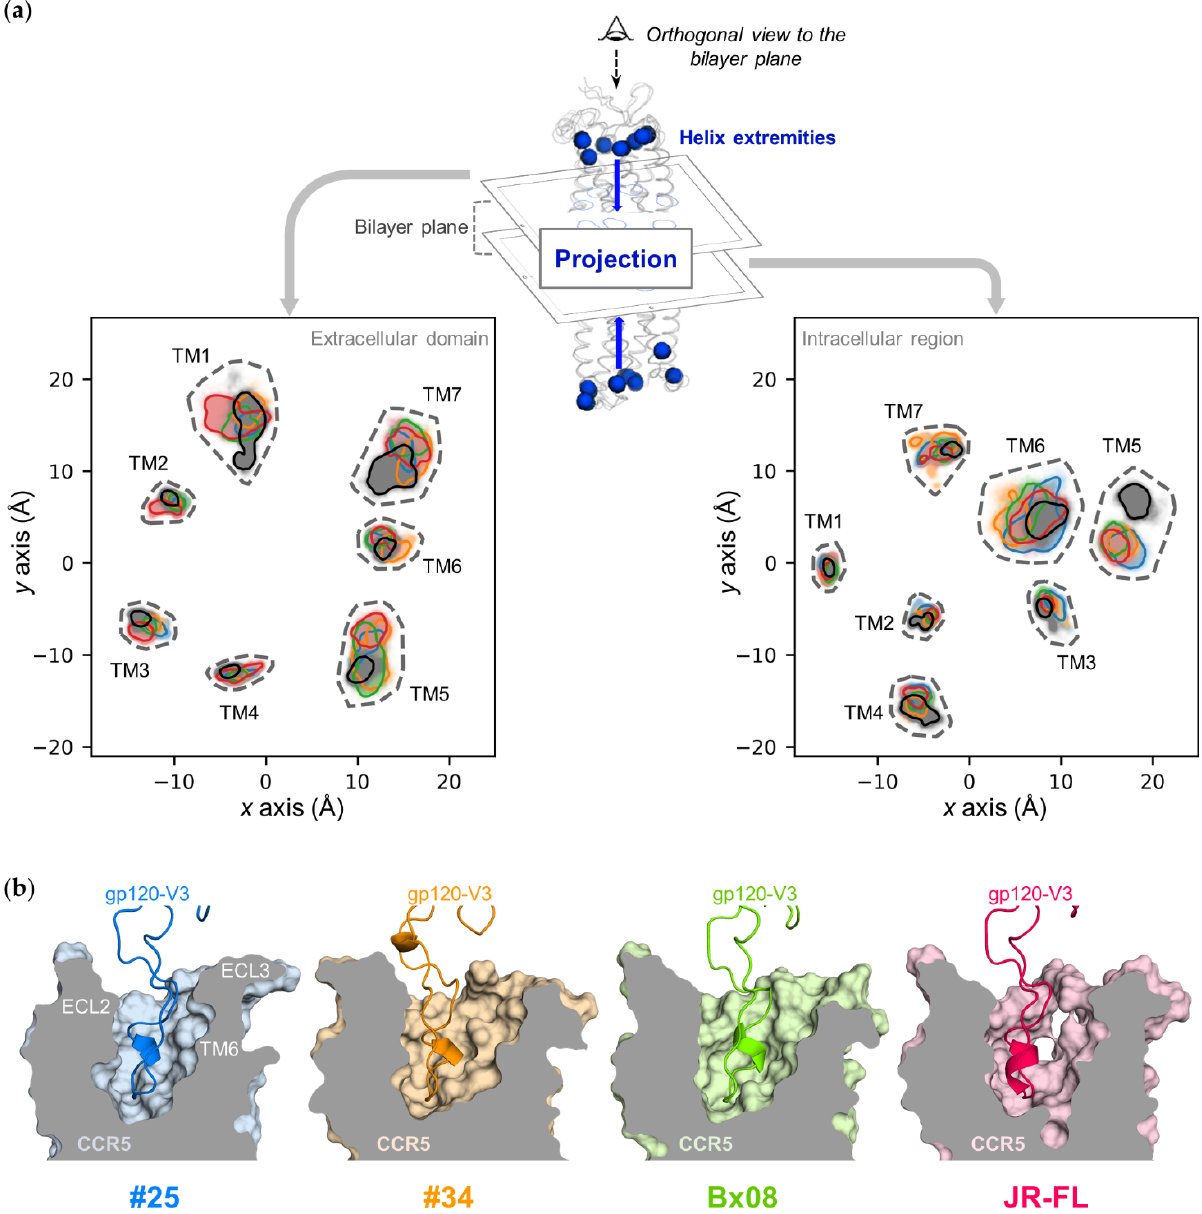
Figure 4. CCR5 transmembrane cavities: ( a ) projection of TMs ends from intracellular (left) and extracellular (right) domains; ( b ) 3D view of clipped CCR5 TM cavity (surface) bound to gp120 V3 loop (cartoon); ( a , b ) Data points and protein structures of CD4–gp120 #25 –CCR5, CD4–gp120 #34 –CCR5, CD4–gp120 Bx08 –CCR5, CD4–gp120 JR-FL –CCR5 and ligand-free CCR5 are colored in blue, orange, green, red and grey, respectively.